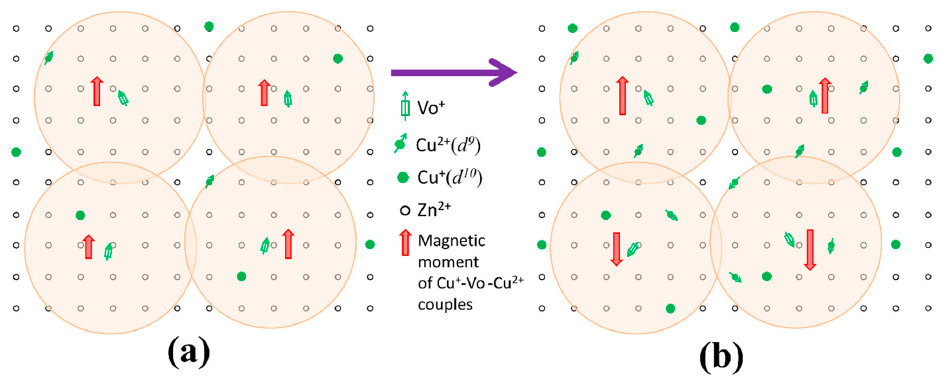
Figure 6. The schematic illustration of the magnetic moment evolution with increasing Cu concentration of lightly Cu-doped ZnO: ( a ) ferromagnetism of Cu + -V O -Cu 2+ couples through an indirect double-exchange model; ( b ) antiferromagnetic Cu + -V O -Cu 2+ couples dominated by Cu ions. The orange circle represents the oxygen vacancy orbital.